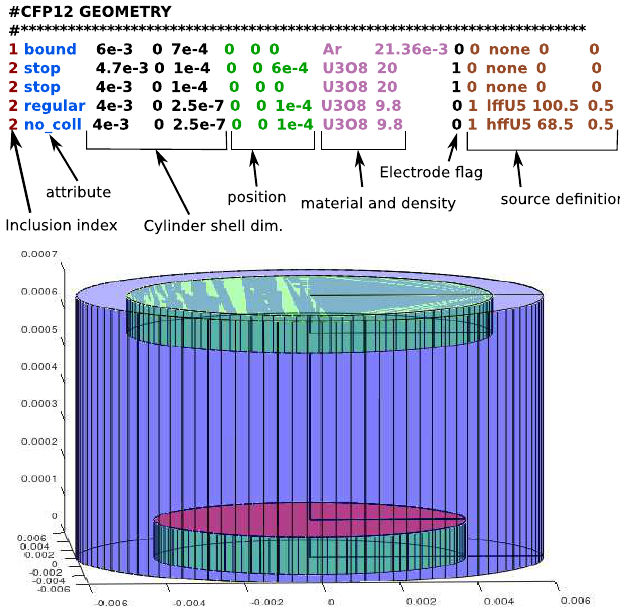
Fig. 7. Example of geometry description for a planar detec- tor. The type of volume is depicted as well as the inclusion index. Second and third volumes represent electrodes, density and composition are useless since the stop attribute makes all the particles stops at volume boundaries. Fourth and fifth vol- umes are heavy ion sources, to avoid undetermined states during heavy ion transport, one volume is made transparent to